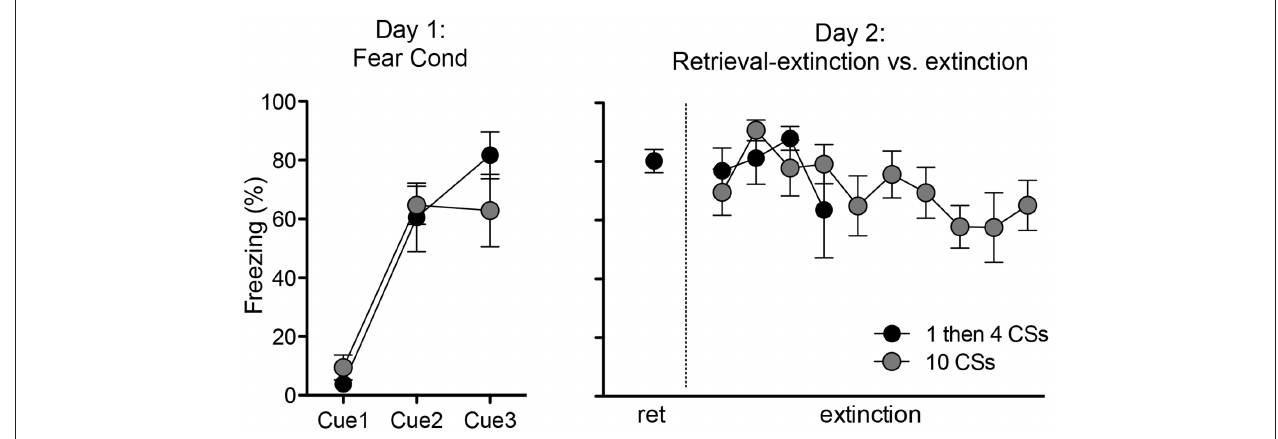
FIGURE 1 | Freezing during fear conditioning with tone-shock pairings on Day 1 and tone presentations on Day 2. Rats in both groups showed fear acquisition and displayed comparable freezing levels on Day 1. On Day 2, rats in the 1 then 4 CSs group ( n = 6) received a single tone presentation and then four additional tone presentations 15 min later to initiate the retrieval-extinction session, while rats in the 10 CSs group ( n = 6) received 10 tone presentations to initiate the standard extinction